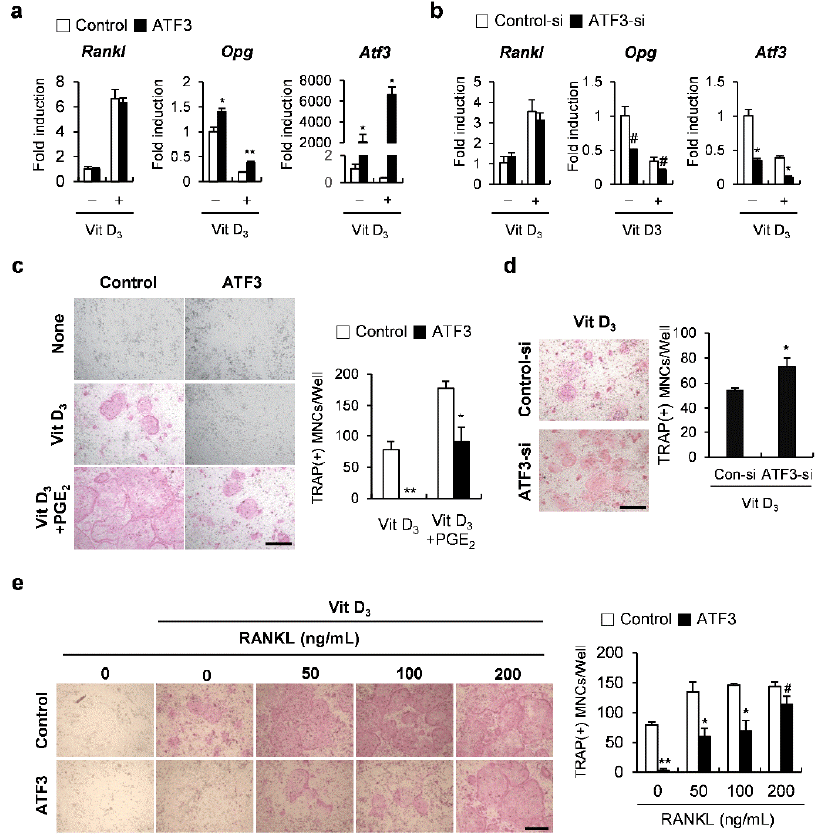
Figure 2. ATF3 augments OPG expression in osteoblasts. ( a ) Primary osteoblast precursors trans- duced with pMX-IRES-EGFP (control) or ATF3 retrovirus were cultured in the presence or absence of Vit D 3 . The expression levels of the indicated genes were analyzed by real-time PCR. ( b ) Primary osteoblast precursors transfected with negative control siRNA (control-si) or ATF3 siRNA (ATF3-si) were cultured in the presence or absence of Vit D 3 . The expression levels of the indicated genes were analyzed by real-time PCR. ( c ) Primary osteoblast precursors were transduced with pMX-IRES-EGFP (control) or ATF3 retrovirus and were co-cultured with bone marrow cells in the presence or absence of Vit D 3 and PGE 2 . The cultured cells were stained for TRAP (left panel). TRAP-positive multinucleated cells were quantified (right panel), scale bar: 200 µm. ( d ) Primary osteoblast precursors were transfected with control siRNA (control-si) or ATF3 siRNA (ATF3-si) and were co-cultured with bone marrow cells in the presence or absence of Vit D 3 . The cultured cells were stained for TRAP (left panel). TRAP-positive multinucleated cells were quantified (right panel), scale bar: 200 µm. ( e ) Primary osteoblast precursors were transduced with pMX-IRES-EGFP (control) or ATF3 retrovirus and were co-cultured with bone marrow cells in the presence or absence of Vit D 3 and with the indicated concentrations of exogenous RANKL. The cultured cells were stained for TRAP (left panel). TRAP-positive multinucleated cells were quantified (right panel), scale bar: 200 µm. # p < 0.05, * p < 0.01, ** p < 0.001 vs. control.